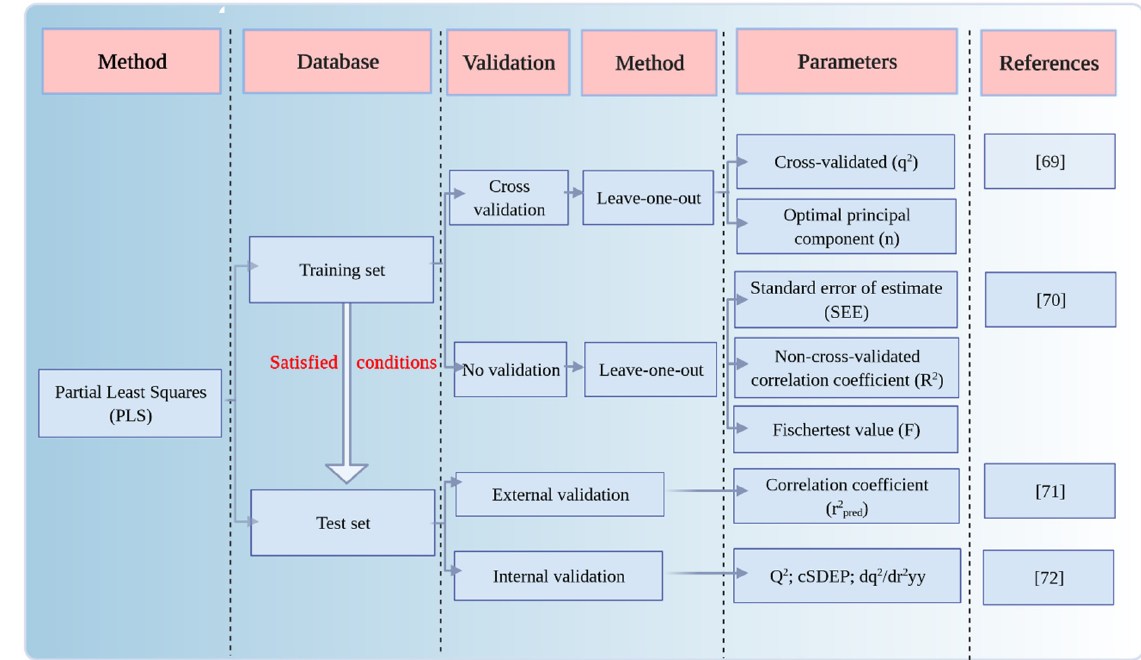
Figure 3. The specific method and the associated parameters of model construction (created with https://biorender.com (accessed on 9 October 2017)).